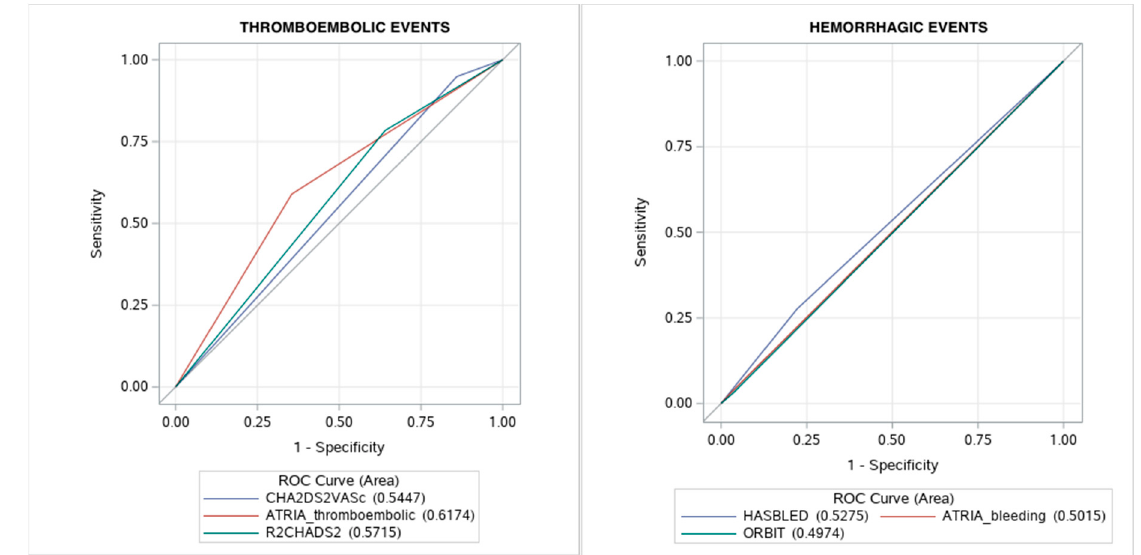
Figure 2. Predictive value of thromboembolic and bleeding risk scores. Abbreviations: ROC, receiver operating characteristic.